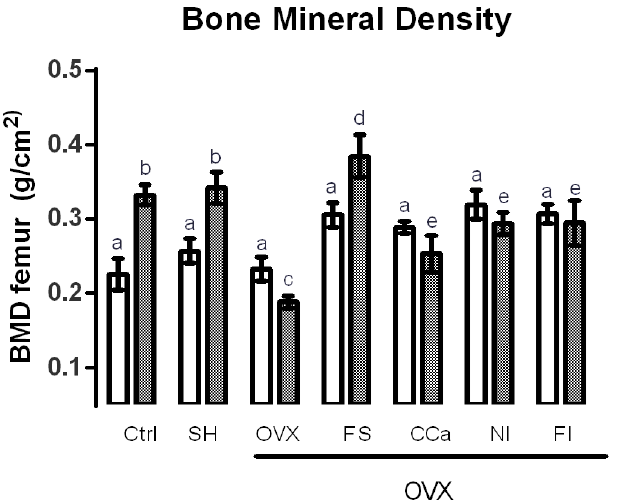
Figure 3. Bone mineral density in experimental groups. The results represent the average ± SD of experimental groups, n = 5 rats/group. Means in bars with different letters indicate significant differences ( p ≤ 0.05) between groups with Tukey’s test. Ctrl = control group, SH = sham group, OVX = ovariectomized group fed with AIN-93M, FS = ovariectomized group fed with diet supplemented with soluble fiber extracted from O. ficus-indica , CCa = ovariectomized group fed with diet supplemented with calcium citrate, NI = ovariectomized group fed with diet supplemented with O. ficus-indica powder, FI = ovariectomized group fed with diet supplemented with insoluble fiber extracted from O. ficus-indica .